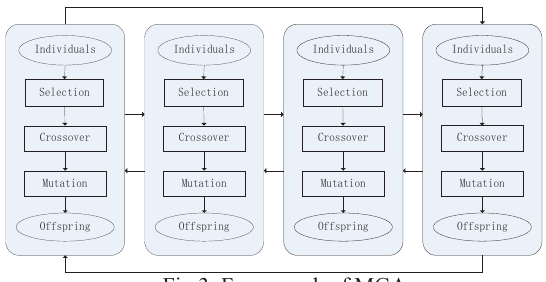
Fig.3. Framework of